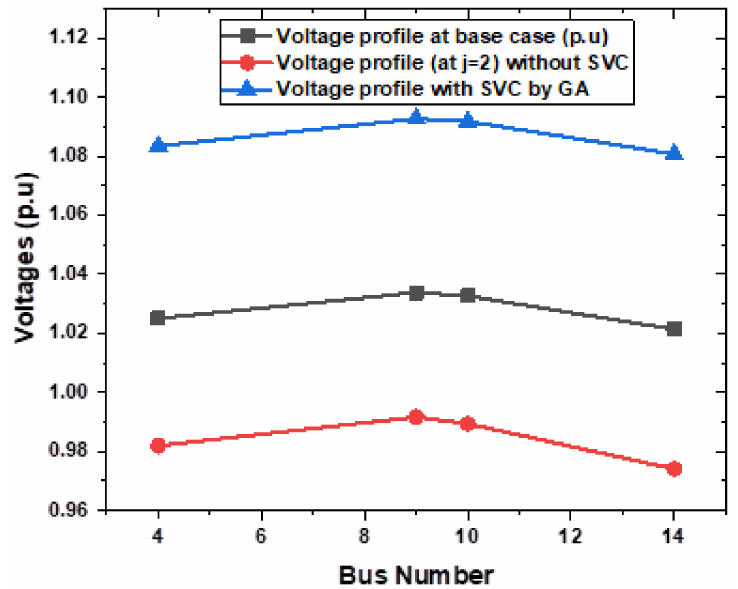
Figure 6. Volage profile of IEEE 14-bus system.